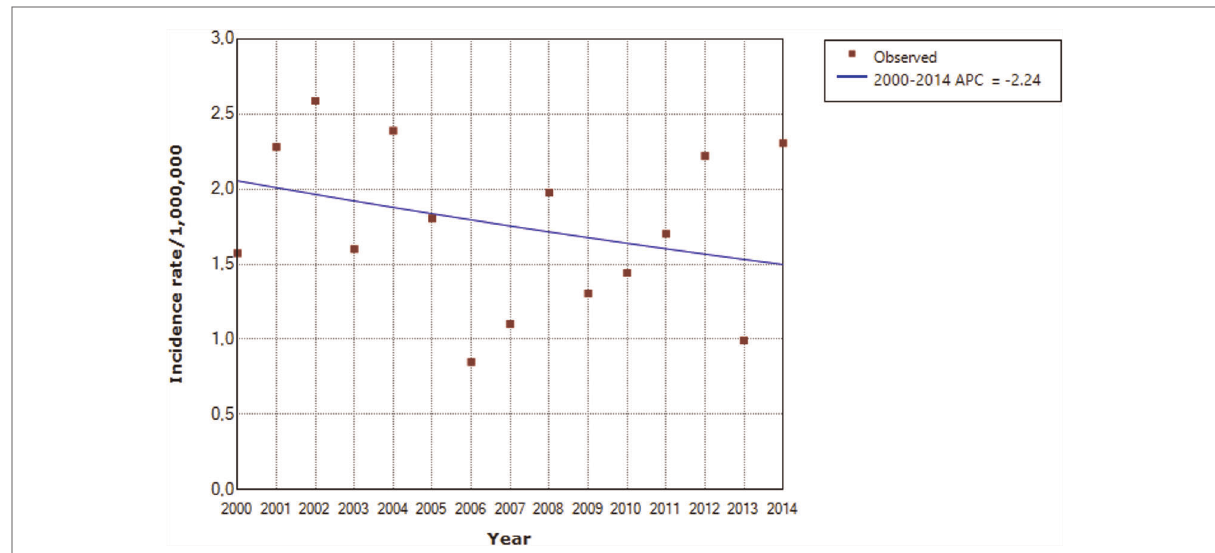
FIGURE 5 Time series from 2000 to 2014 demonstrating stationarity (stable trend) of the combined incidence of retinoblastoma in children and adolescents aged 0 to 19 years in six Brazilian